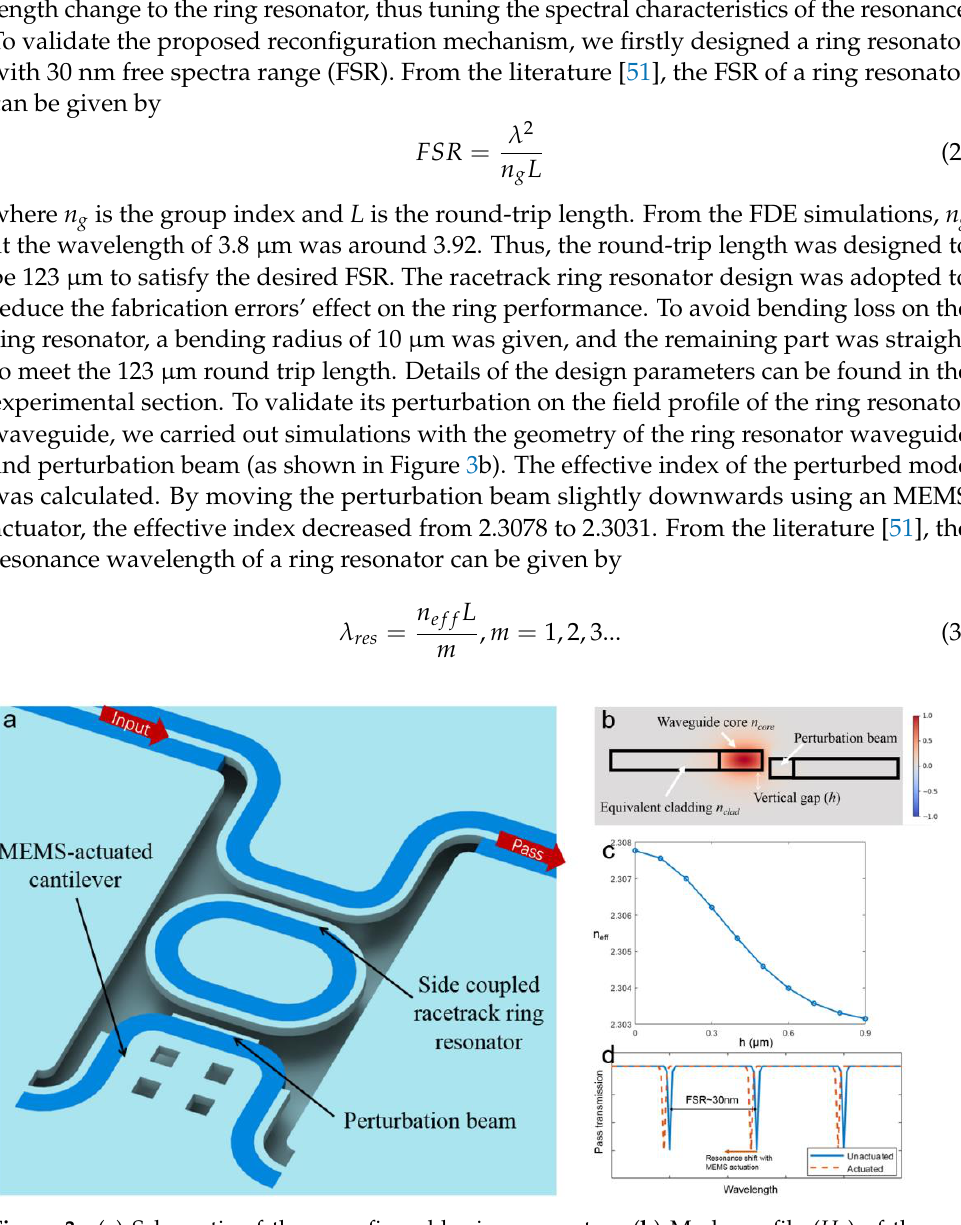
Figure 3. ( a ) Schematic of the reconfigurable ring resonator. ( b ) Mode profile ( H y ) of the perturbed waveguide mode. ( c ) Simulation results of the effective index n eff under perturbation at the wavelength of 3.9 μm. ( d ) Schematic pass transmission spectrum of the ring resonator under the MEMS tuning.